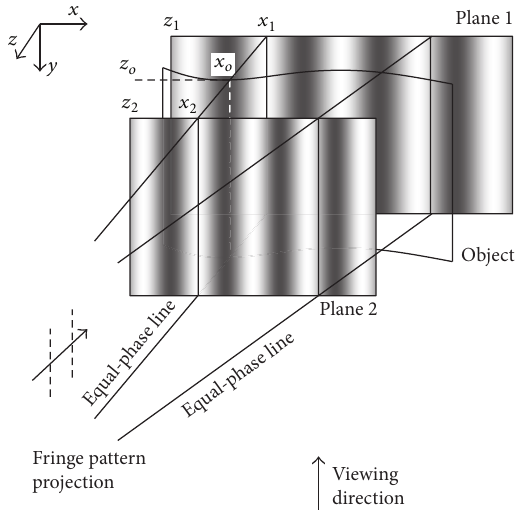
Figure 2: Calibration of phase-to-height relationship.